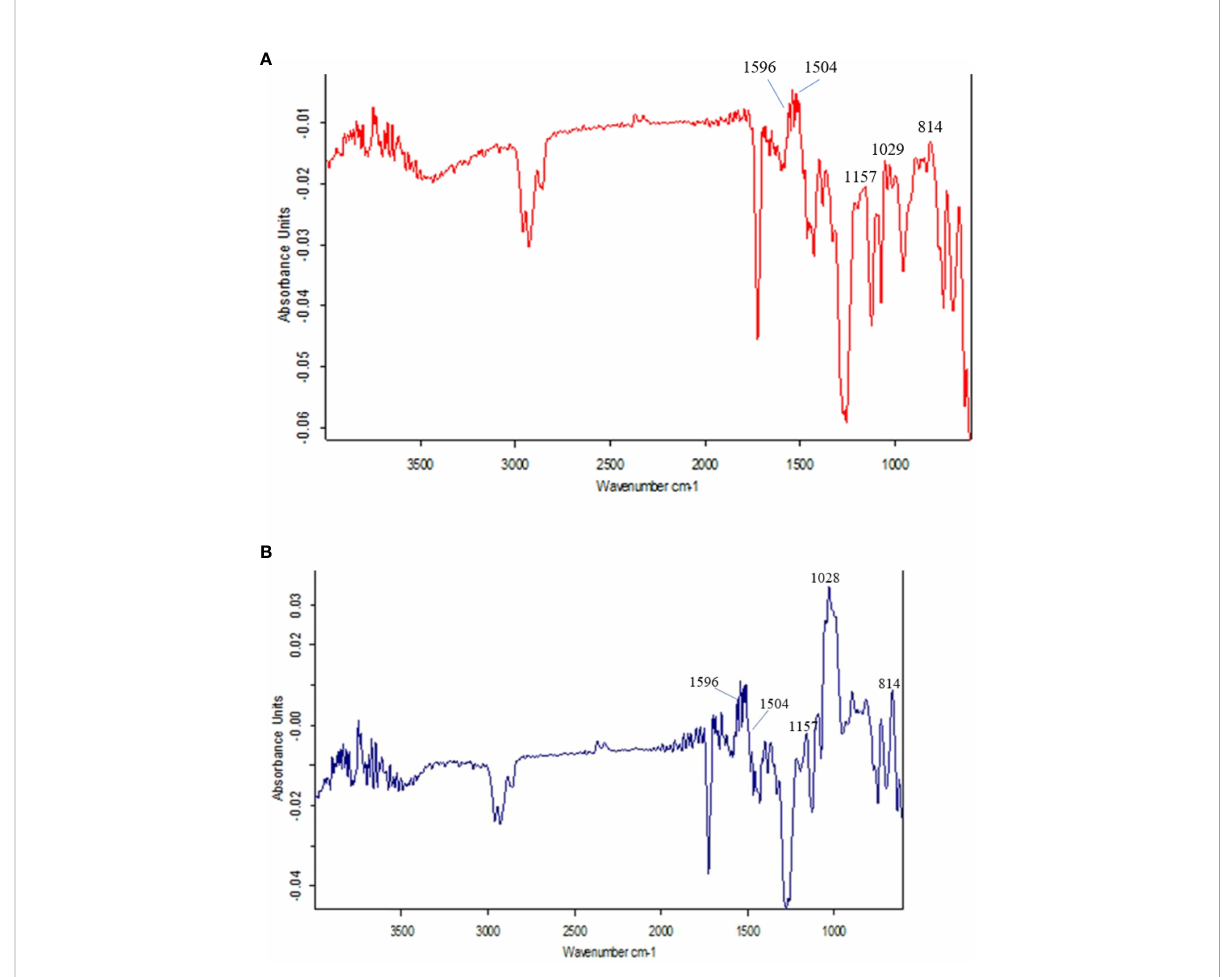
FIGURE 4 Results of FTIR spectra of the components in cell wall of (A) lodging tolerant mutant PMW-2016-1 and (B) parent DPW 621-50 wheat